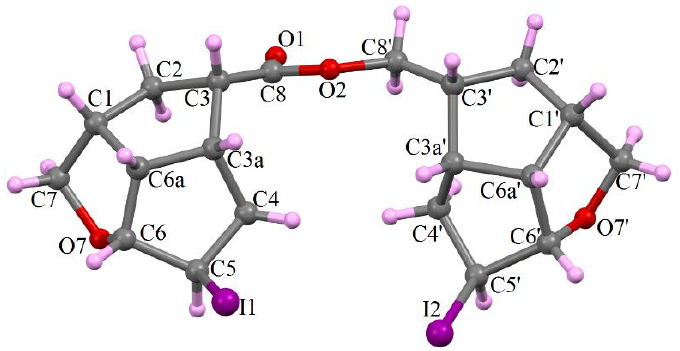
Figure 4. X-Ray molecular configuration of the asymmetric unit for secondary compound 6b .